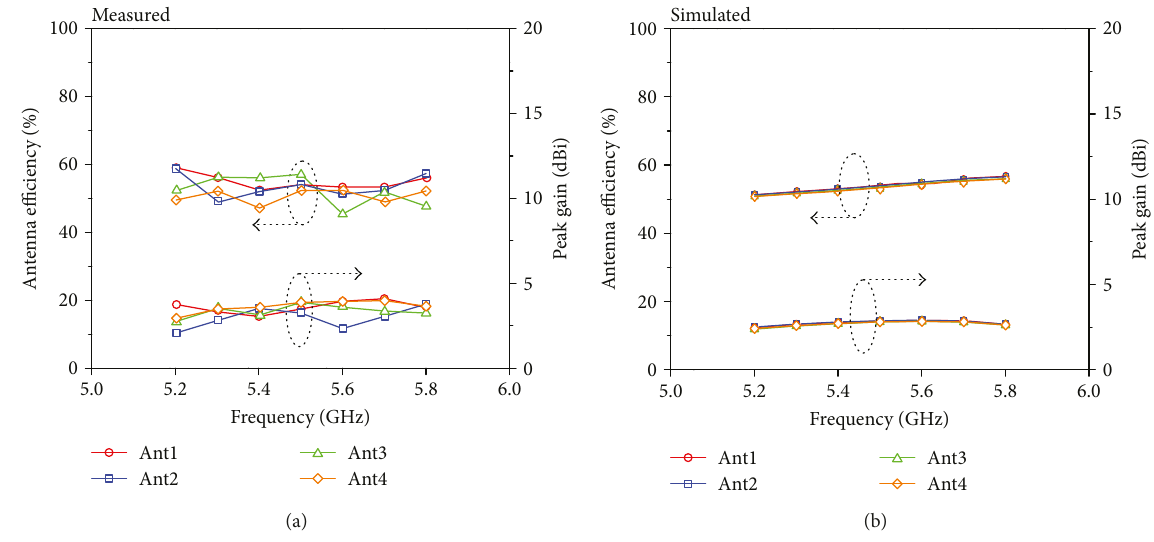
Figure 14: (a) Measured antenna e ffi ciency and peak gain for the four-element MIMO antenna worn on the phantom hand; (b) simulated antenna e ffi ciency and peak gain for the four-element MIMO antenna mounted on the wrist.